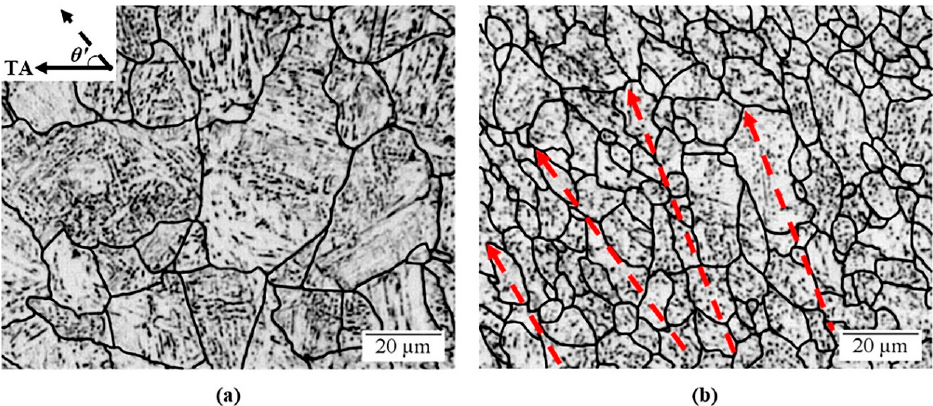
Figure 10. Higher magnification LOM micrographs of the prior austenite microstructures produced via ( a ) High T Finish and ( b ) Low T Finish simulations highlighting differences in morphology. The 0.724 radial position is shown in both. The torsional axis (TA) is horizontal to the page. Dashed lines in ( b ) show the inclination angles of various prior austenite grains. Etched with a modified Béchet-Beaujard reagent, and prior austenite grain boundaries are highlighted in black.